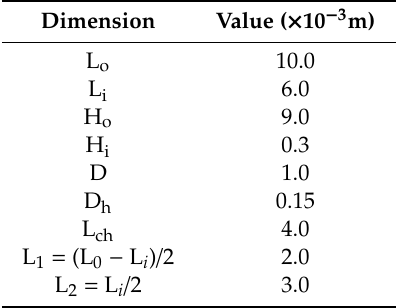
Figure 4. Detailed view of the microchannel walls with ( a ) regular trapezoidal secondary flow passages and ( b ) parallel secondary flow passages. Table 1. Geometric configuration of the heat sinks.